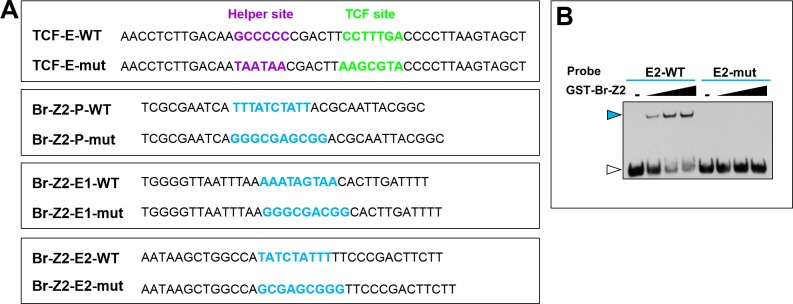
EMSA assay showing specific binding of TCF or Br-Z2 to their binding site in cut promoter or intron2-enhancer region.(A) The sequence of the EMSA probes containing wild type (WT) or mutant (mut) form of TCF or Br-Z2-binding sites (bold) in cut enhancer or promoter region. E: enhancer; P: promoter. The consensus sequences of TCF-binding site, helper site and Br-Z2-binding site are CCTTTG(A/T); GCCGCC and TTT(A/T)(A/T)CTATTT respectively (Archbold et al., 2014; Chang et al., 2008; von Kalm et al., 1994). (B) EMSA demonstrating the interaction of the Br-Z2 DNA-binding domain with DNA probes bearing WT or mutant sequence of a putative Br-Z2-binding site in cut enhancer region (E2). Note that the blue arrowhead indicates the DNA-protein complexes, whereas the white arrowhead indicates free probes.